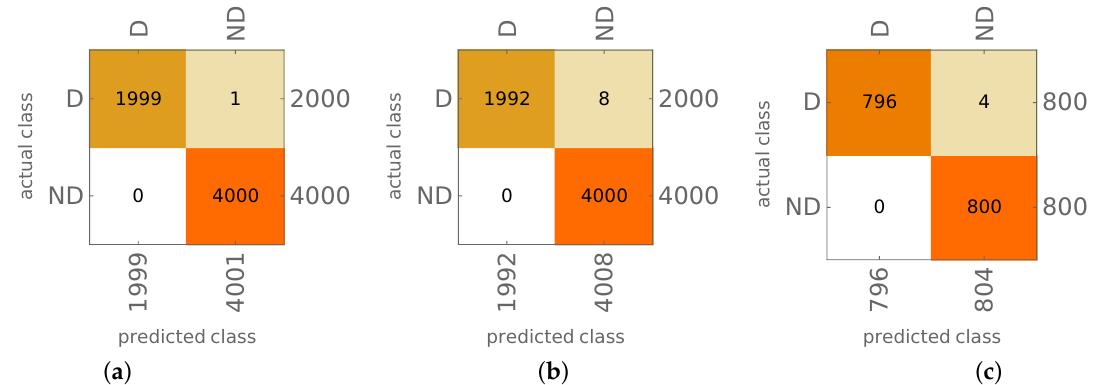
Figure 13. The results of PA model identification (22 mode shapes involved): ( a ) patterns used for CNN learning, 4 and 16 composite layers, ( b ) testing, 8 and 32 composite layers, ( c ) testing of PA procedure for different